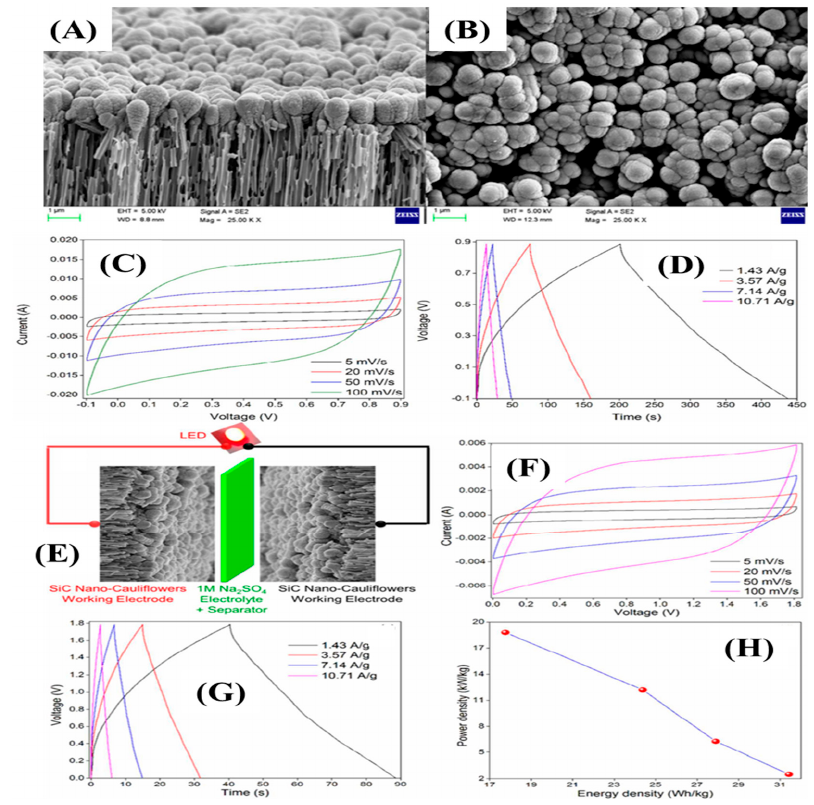
Figure 13. FE-SEM images ( A , B ); CV and GCD curves at various scan rates (5–100 mV/s) and current densities (1.43–10.71 A/g) ( C , D ); schematic representation of symmetric device ( E ); CV and GCD curves of symmetric device at various scan rates and current densities ( F , G ); ragone plot of the device ( H ) [109].